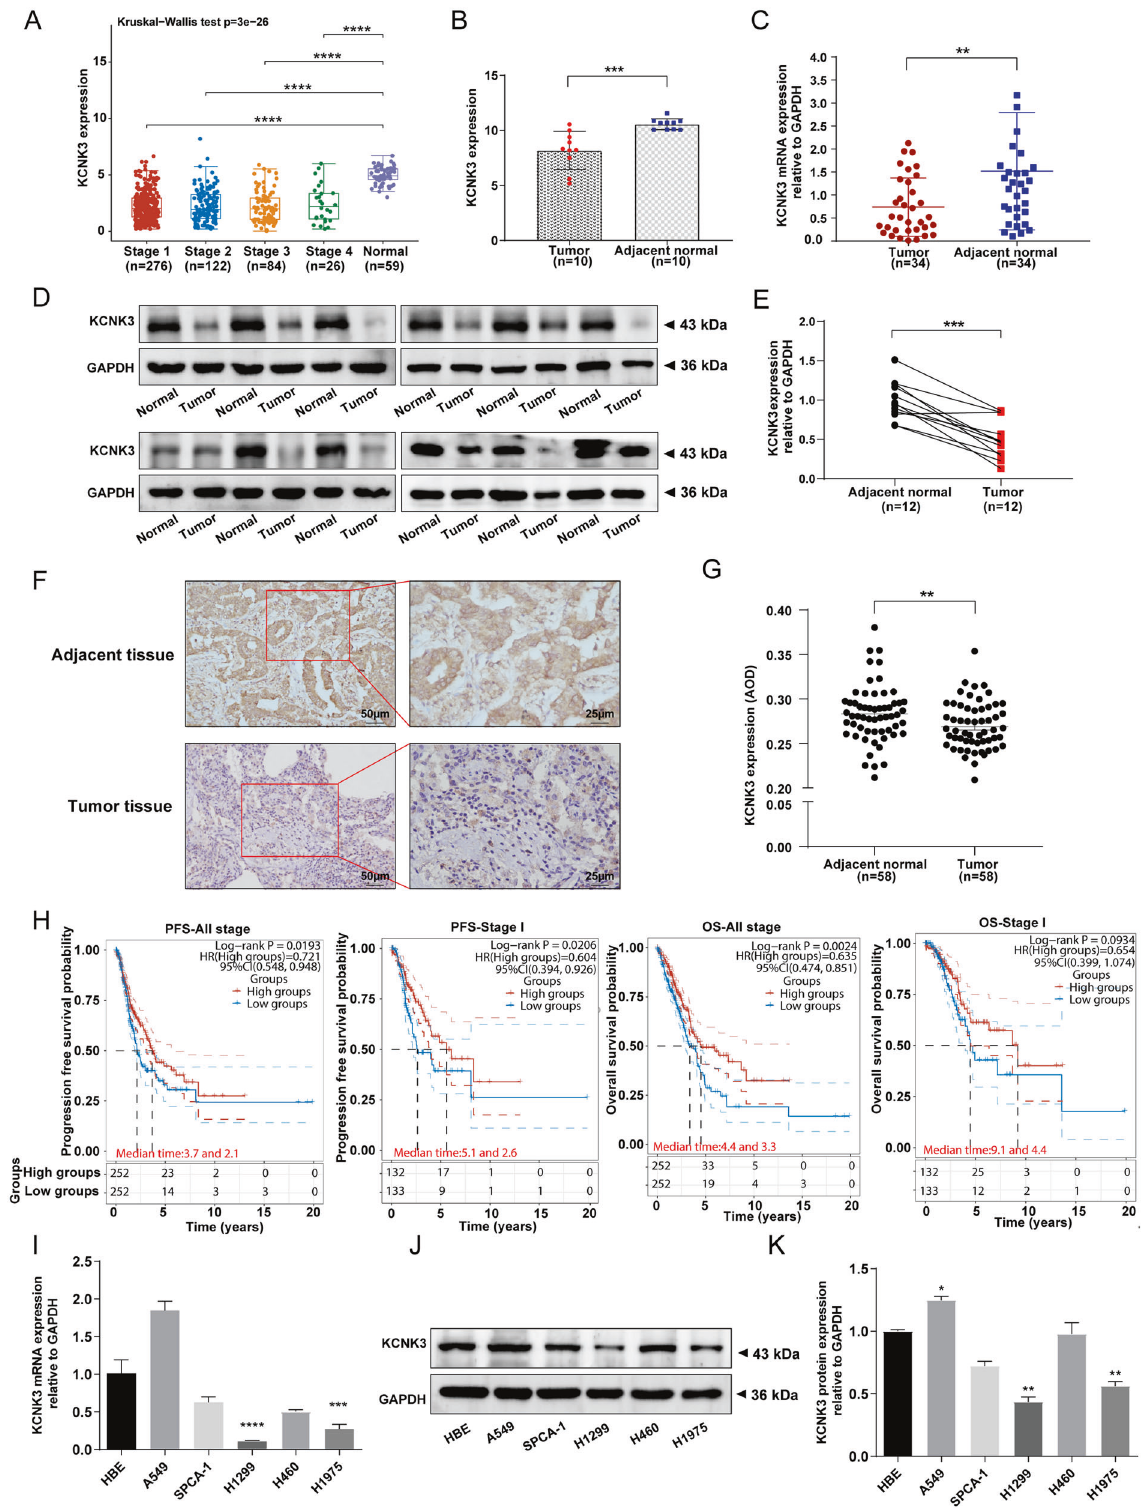
Fig. 1 Low KCNK3 expression in LUAD tissues was correlated with poor prognosis. A The KCNK3 mRNA levels in LUAD tissues compared with the normal lung tissues from TCGA database. B , C The mRNA expression of KCNK3 in stage I LUAD patients was determined by RNA sequencing ( n = 10) and qRT-PCR ( n = 34). D , E Western blot analysis of KCNK3 protein expression in stage I LUAD tissues and corresponding adjacent tissues, with results normalized relative to the expression of GAPDH ( n = 12). F , G KCNK3 protein expression in stage I LUAD tissues and adjacent tissues were detected by IHC and quantitative analysis by using average optical density (AOD, AOD = IOD/area, n = 58, scale bar 50 or 25 µm). H The prognostic values of KCNK3 in LUAD patients from TCGA by using a clinical bioinformatics database (www.aclbi.com). I – K KCNK3 mRNA and protein expression levels of LUAD cell lines were assessed by qRT-PCR and western blot, respectively. (OS, overall survival; PFS, progression-free survival. * P < 0.05, ** P < 0.01, *** P < 0.001, **** P < 0.0001). Cell Death Discovery (2022)